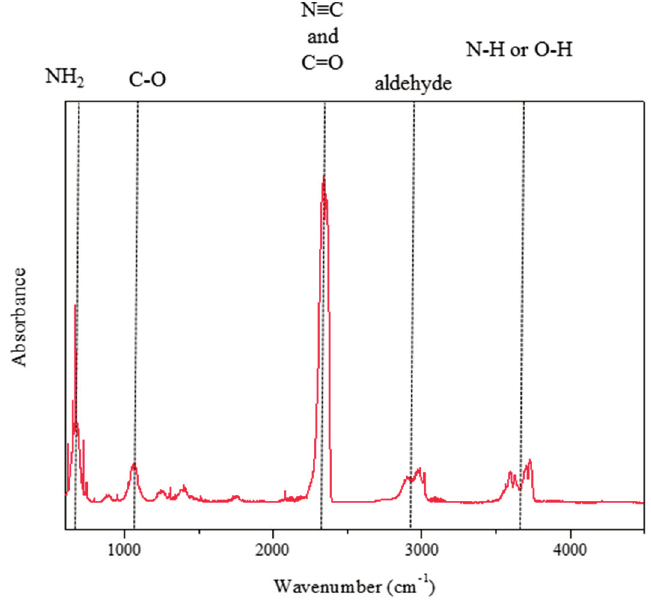
Figure 7. FT-IR spectrum of explosion gas of an mixture hypergolic chemicals with [TMH] + [CN] − and HOCH 2 CH 2 NHNH 2 using H 2 O 2